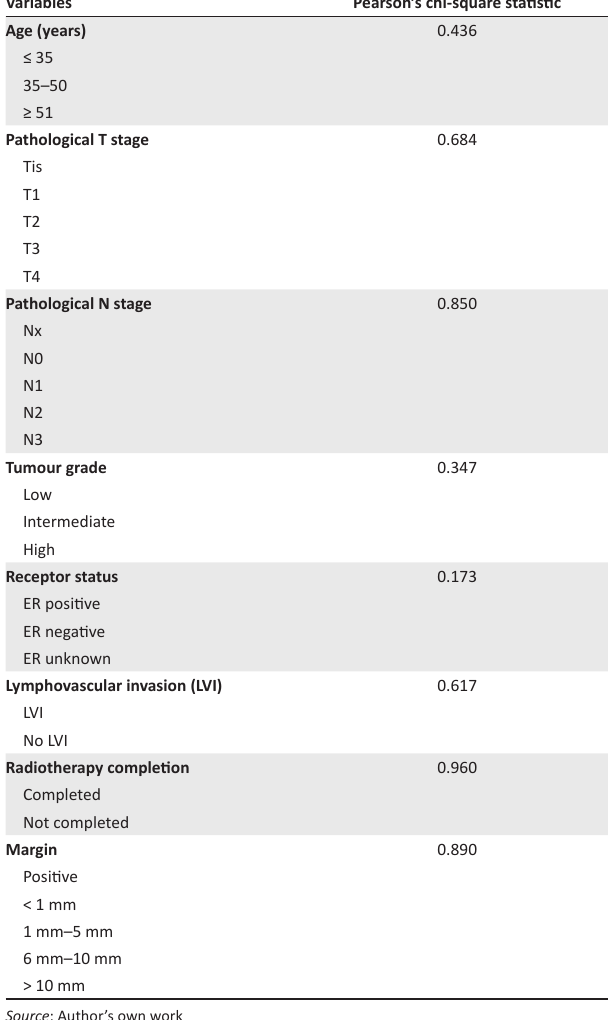
TABLE 3: Effect of different variables on local